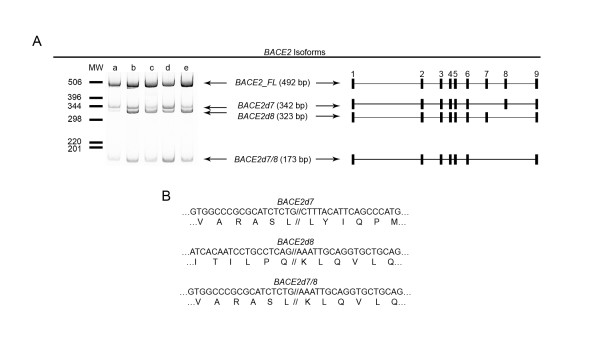
BACE2 isoforms present in human brain. Human brain cDNA samples were screened for BACE2 isoforms using conventional PCR amplification across the alternatively spliced regions of exons 7 and 8. (A) Four alternatively spliced BACE2 isoforms were detected among multiple individuals. (B) Direct sequencing of the resulting splice variants confirmed their identities as BACE2d7, BACE2d8 and BACE2d7/8. Deletion of BACE2 exon 7 results in an in-frame deletion of 50 amino acids whereas deletions of BACE2 exon 8 or exons 7 and 8 lead to a frameshift and premature truncation of the protein.